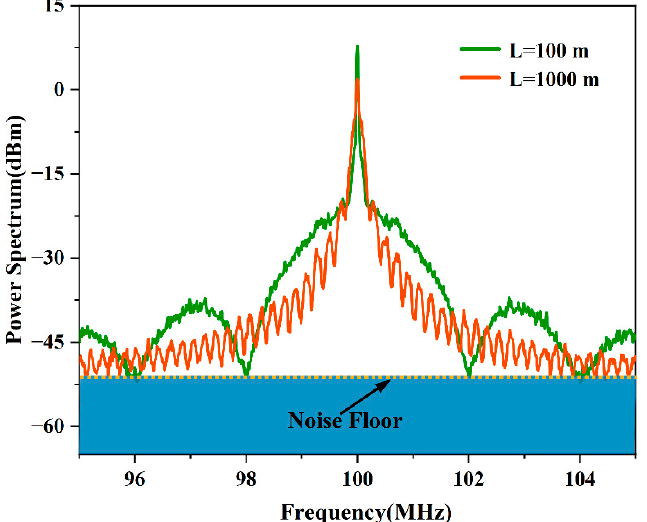
Figure 9. Plots showing the experimentally obtained signal PSD functions for delay fiber lengths of 100 m and 1000 m.